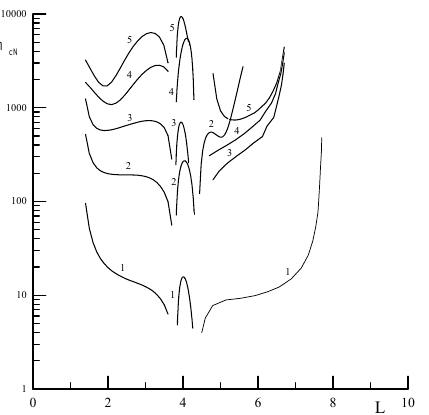
Fig. 7. Dependency of the critical value of the azimuthal wave number m cN for the first five parallel harmonics of standing Alfv´en waves. The m>m cN values correspond to κ N > 1, when the struc- ture of oscillations across magnetic shells has the form of a “trav- elling wave”. The m<m cN values correspond to κ N < 1, when the structure of oscillations has the “field line resonance” form.